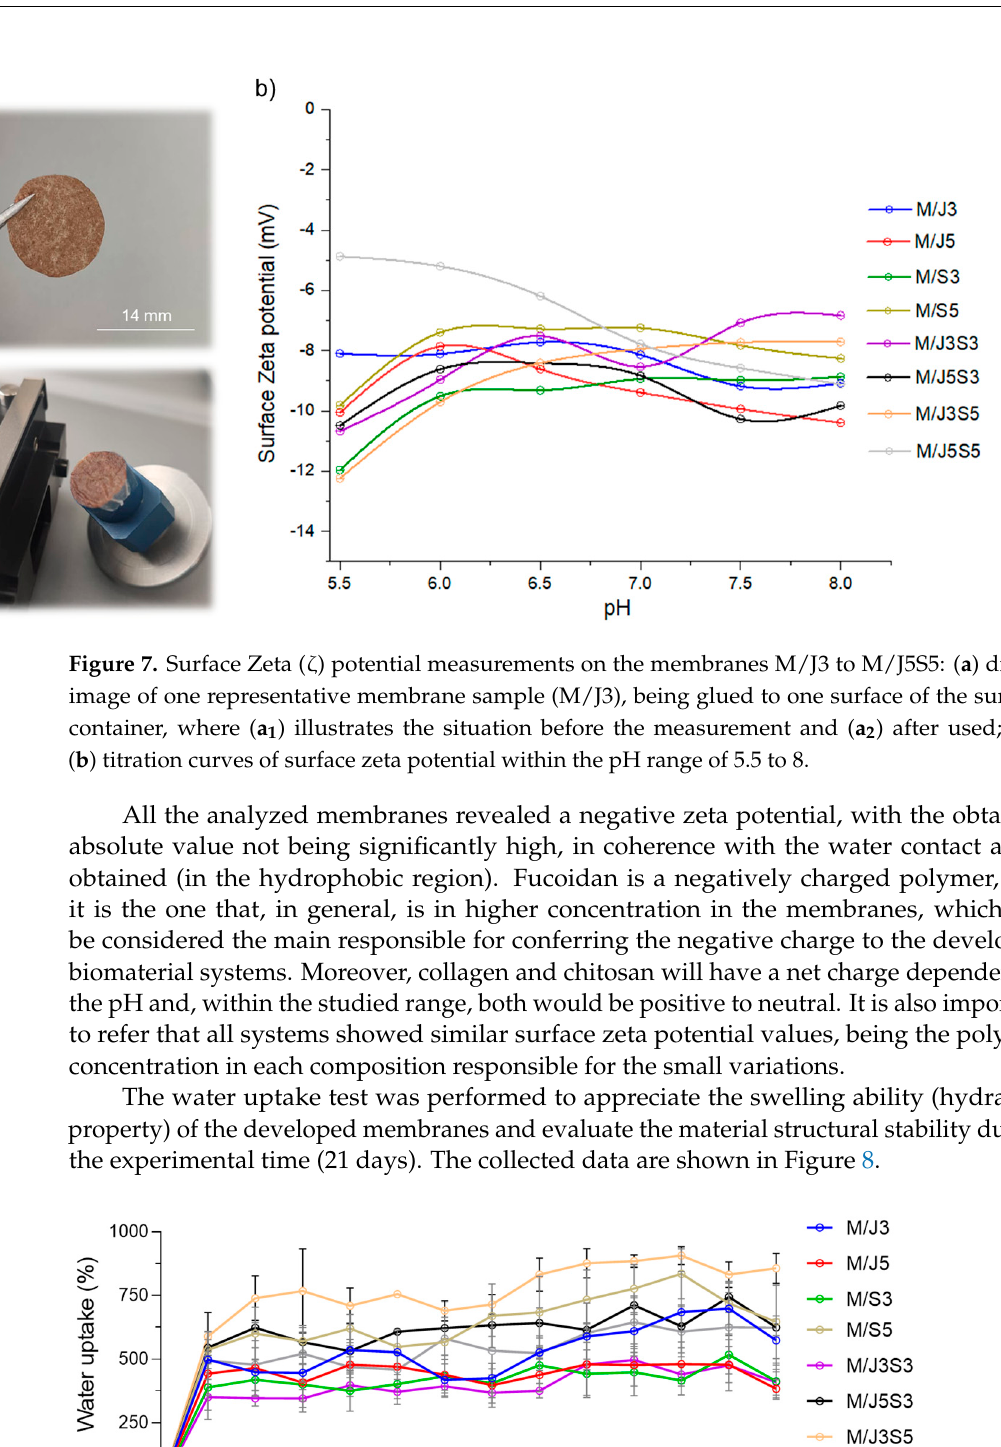
Figure 8. Assessment of the degree of swelling (measured as water uptake) in each membrane (M/J3 to M/J5S5) upon incubation in PBS solution for up to 21 days (504 h). Data are presented as mean ± standard error (n = 3).